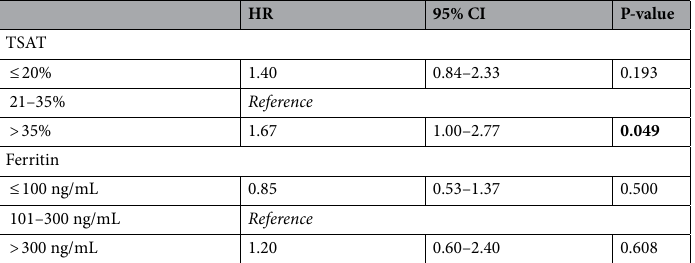
Table 3. Adjusted hazard ratios for outcomes based on iron parameters in multivariate Cox regression analysis (Multivariate analysis was adjusted for recipient and donor age, recipient and donor’s sex, type of transplantation (living donor or deceased donor), history of diabetes mellitus, smoking history, and laboratory tests including hemoglobin, albumin, and estimated glomerular filtration rate at 1 year after kidney transplantation). The primary outcome was composite of all-cause mortality, graft failure, and eGFR ≥ 50%. Graft failure is defined as the development of kidney failure requiring dialysis or KT, or death with a